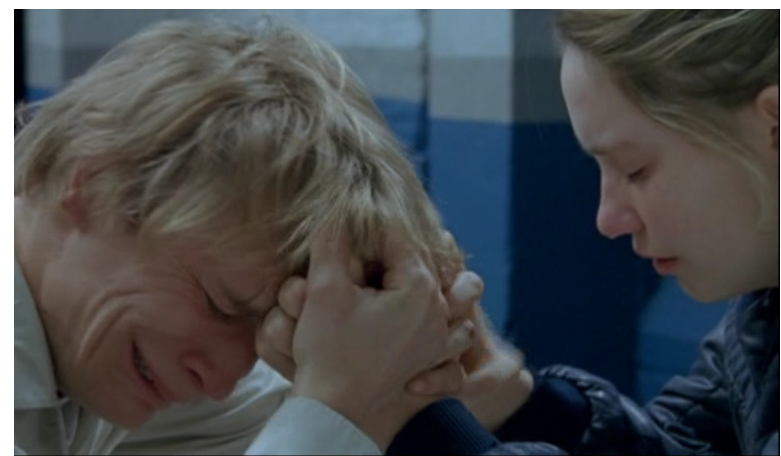
Figure 11. Proximity in L’Enfant.